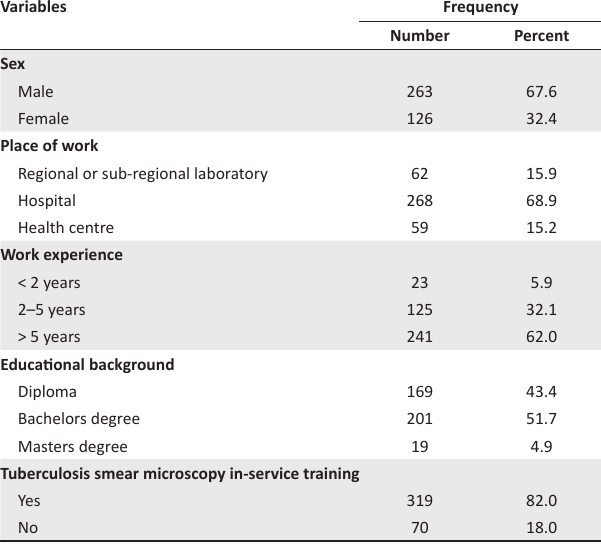
TABLE 2: Demographic characteristics of microscopists at tuberculosis external quality assessment rechecking laboratories in Ethiopia ( N = 389), April–July, 2015.